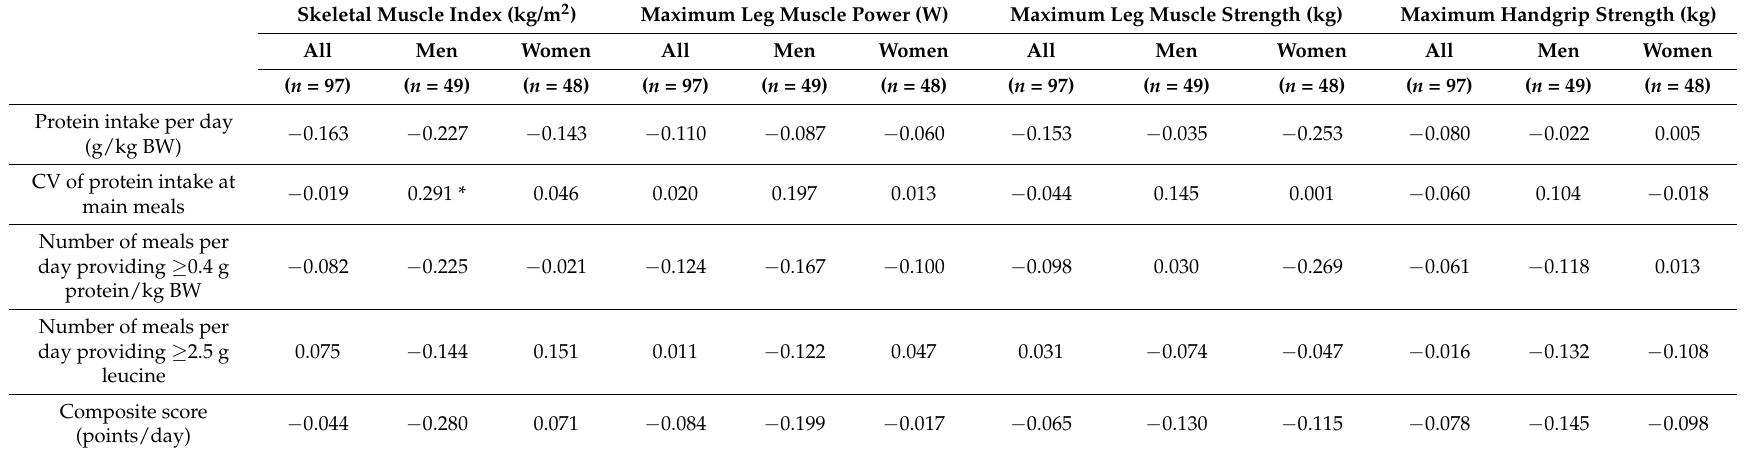
Table 4. Spearman correlation coefficients between mean daily intake of protein, mean coefficient of variance of protein across main meals, mean number of meals providing at least 0.4 g protein/kg BW, mean number of meals providing at least 2.5 g leucine, and mean composite score representing protein intake pattern obtained from 7-day food records and muscle mass, leg muscle power, leg muscle strength, and handgrip strength in healthy community-dwelling older adults and subgroups of male and female